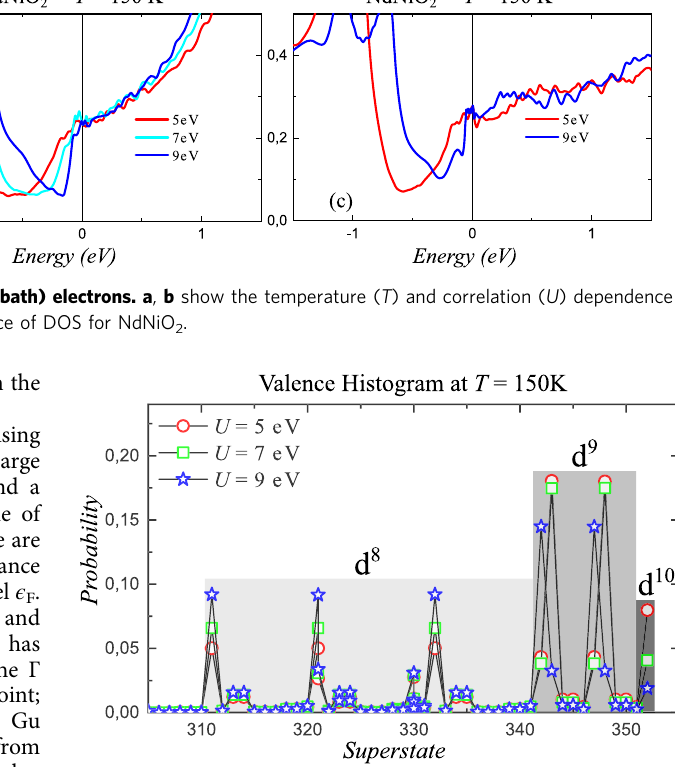
Fig. 6 Ni-d electron valence histogram. DFT + eDMFT calculated atomic histogram of Ni 3 d orbitals at T = 150 K for various values of the correlation parameter U = 5, 7, 9 eV and J = 1 eV, showing the mixture of various d 8 , d 9 and d 10 atomic con fi